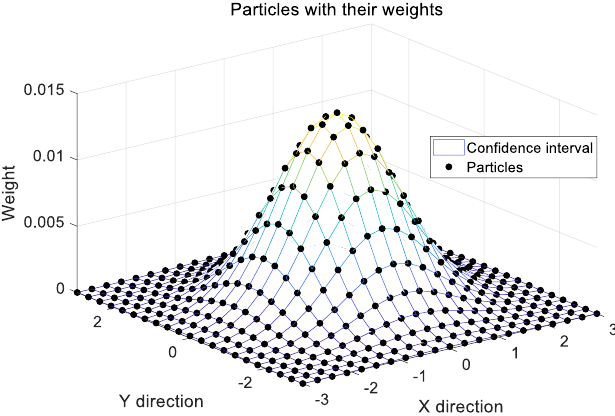
dence interval c for confidence their weights is shown in Figure 2.